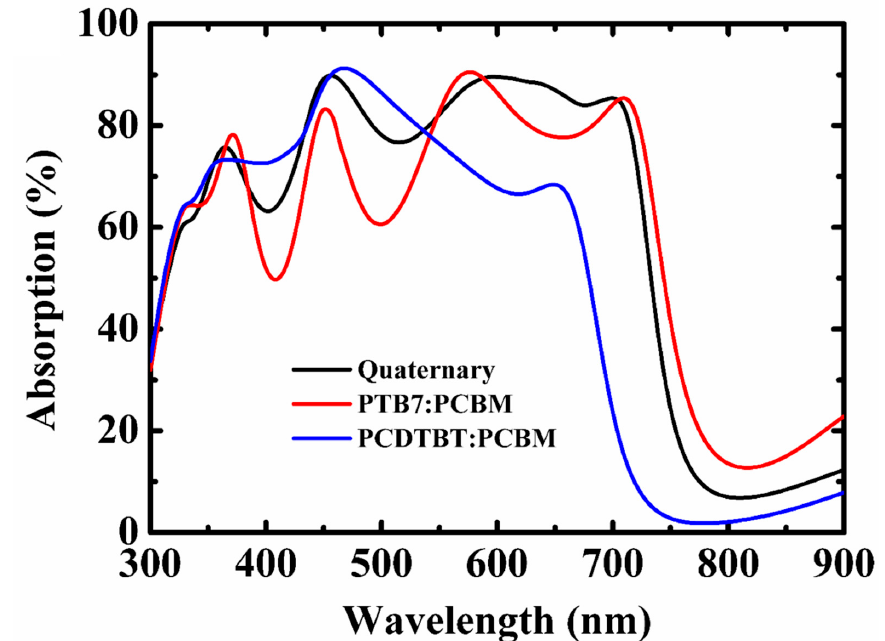
Figure 4. The absorption of quaternary and single BHJ active layers at a thickness of 230 nm. The single BHJs showed absorption similar to the quaternary indoor photovoltaic (IPV), with the quaternary IPV exhibiting a slightly higher absorption than PTB7:PC 71 BM, and a slightly lower absorption than PCDTBT:PC 71 BM at ~450 nm wavelength (LED spectrum’s